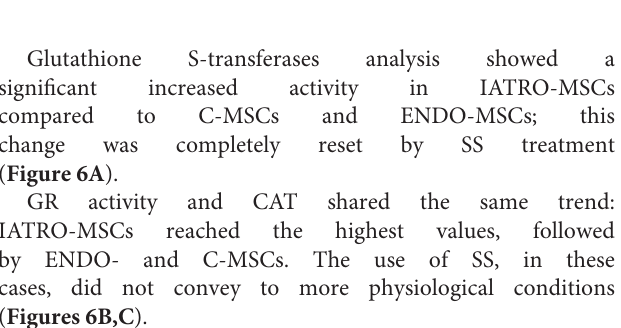
(GR), and (C) catalase (CAT) activity was measured by specific enzymatic assays. Values are reported as mean ± SD of three independent experiments. ∗ p ≤ 0.05 MSCs from CS patients vs. C-MSCs.